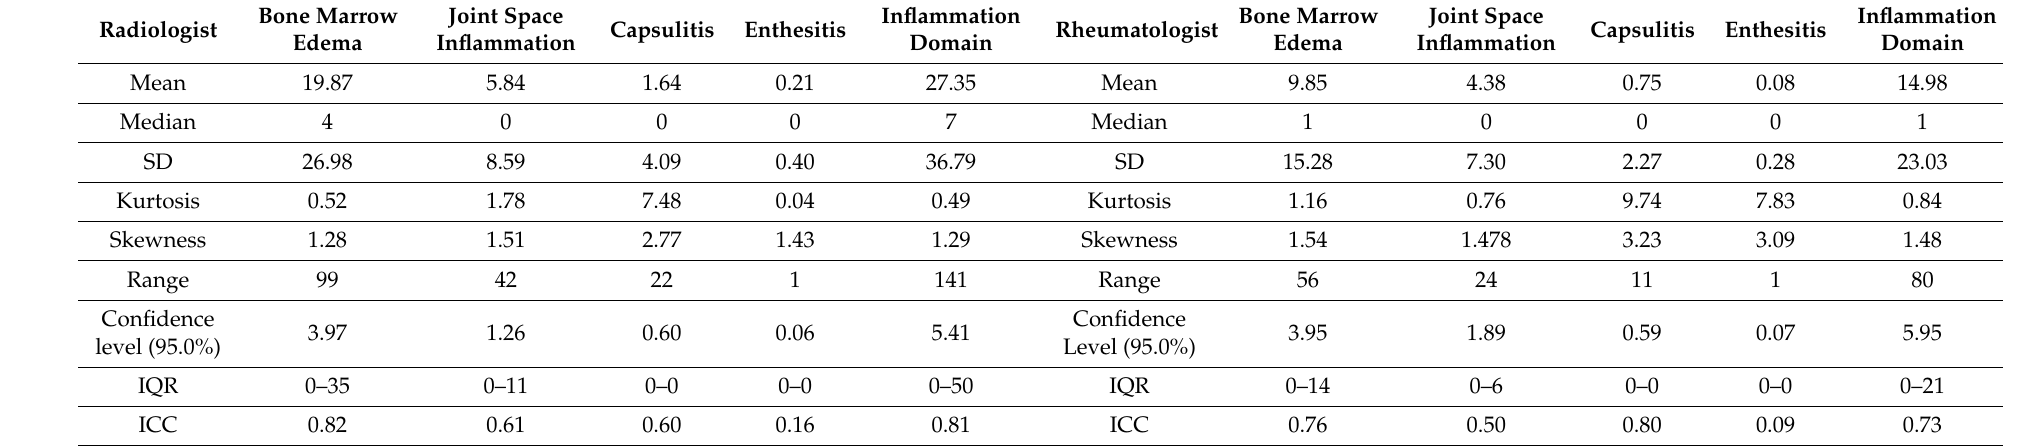
Table 3. JAMRIS-SIJ inflammation components’ descriptive statistic and intraclass correlation coefficients (ICCs) for six radiologists and two